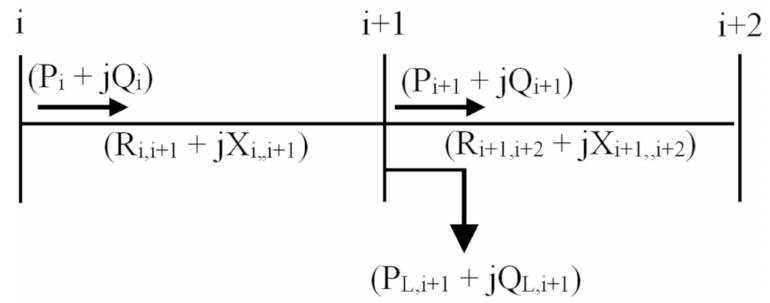
Figure 1. Single-line diagram of a sample radial distribution